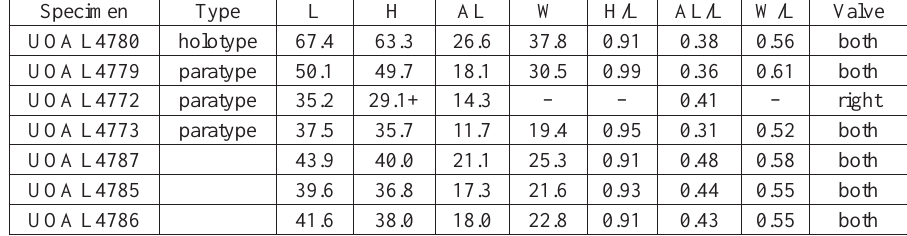
Table 3. Measurements (in mm) of Lucinoma saetheri sp. nov. Abbreviations: AL, anterior length; H, height; L, length; W, width.